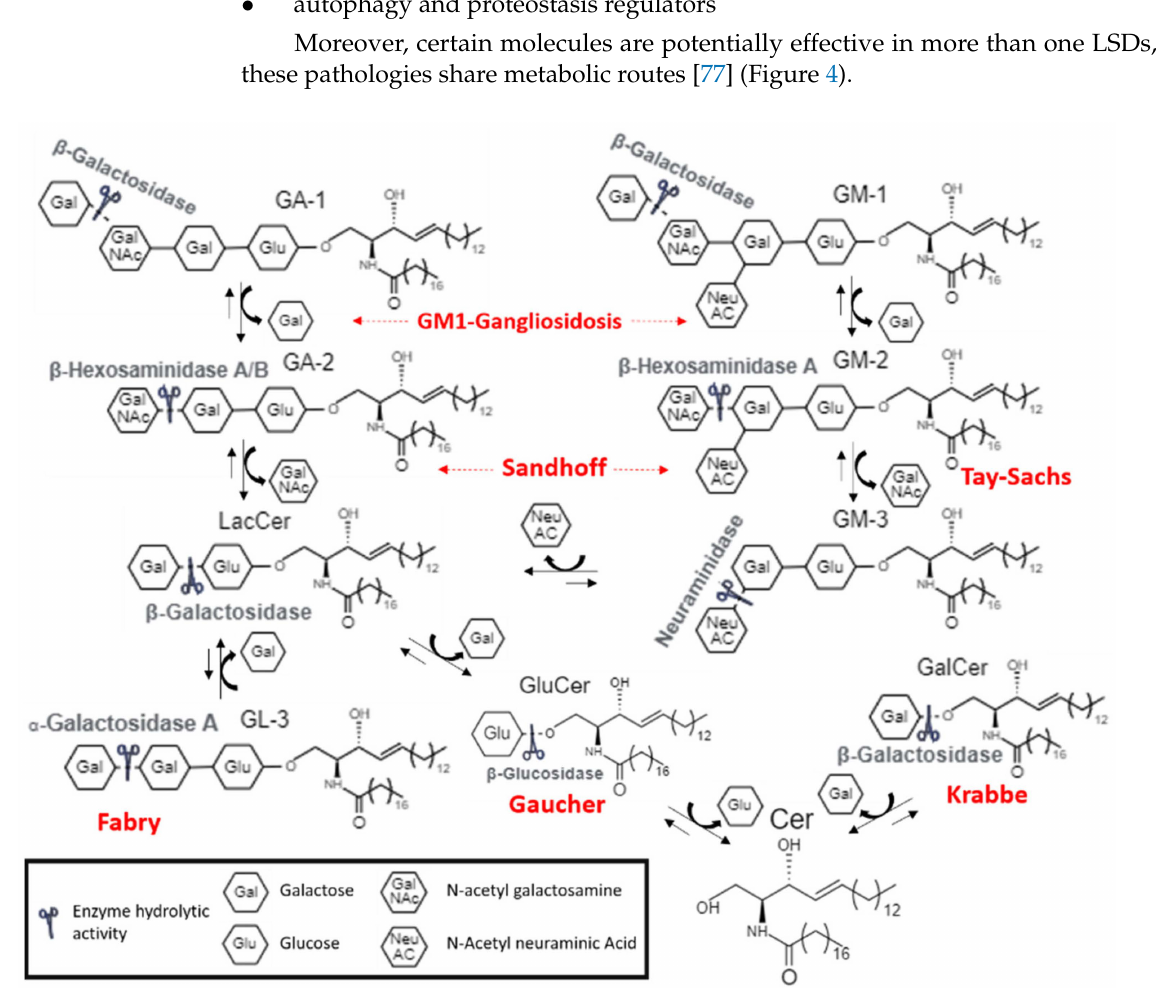
Figure 4. Schematic view of lipid catabolism pathway in the lysosome Enzymes involved in LSDs are